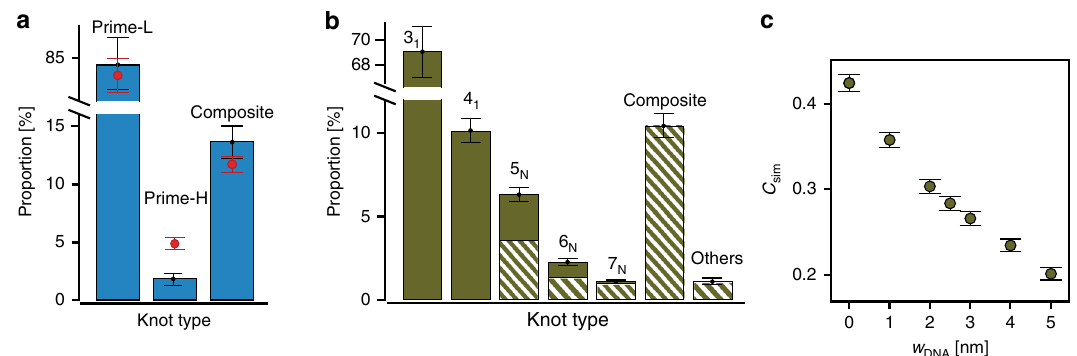
Fig. 3 Percentages of various knot types and the complexity of knotting. a Histogram of experimental (blue bars) and simulated (red crosses) knotting probabilities of lower order prime (prime-L) knots, higher order prime (prime-H) knots, and composite knots. b Proportion of different types of knots in a simulated lambda DNA (width, w DNA = 2.5 nm). Solid bars represent lower order prime (prime-L) knots while the partially fi lled bars represent complex (prime-H and composite) knots. c Plot of simulated knotting complexity ( C sim ) of lambda DNA, as a function of effective DNA width ( w DNA ) indicates the strong dependence of the occurrence of complex knots on the effective diameter of DNA. All error bars show the statistical error, assuming Poisson statistics. Source Data are provided as a Source Data